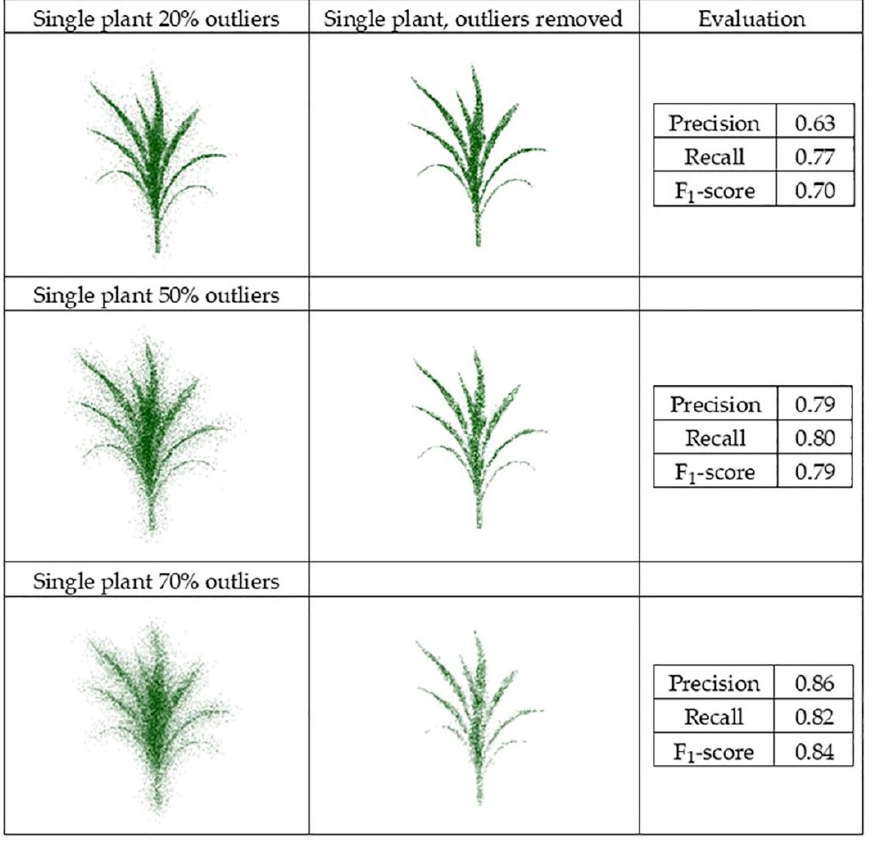
Figure 16. PointCleanNet outlier removal for a point cloud based on a single plant.